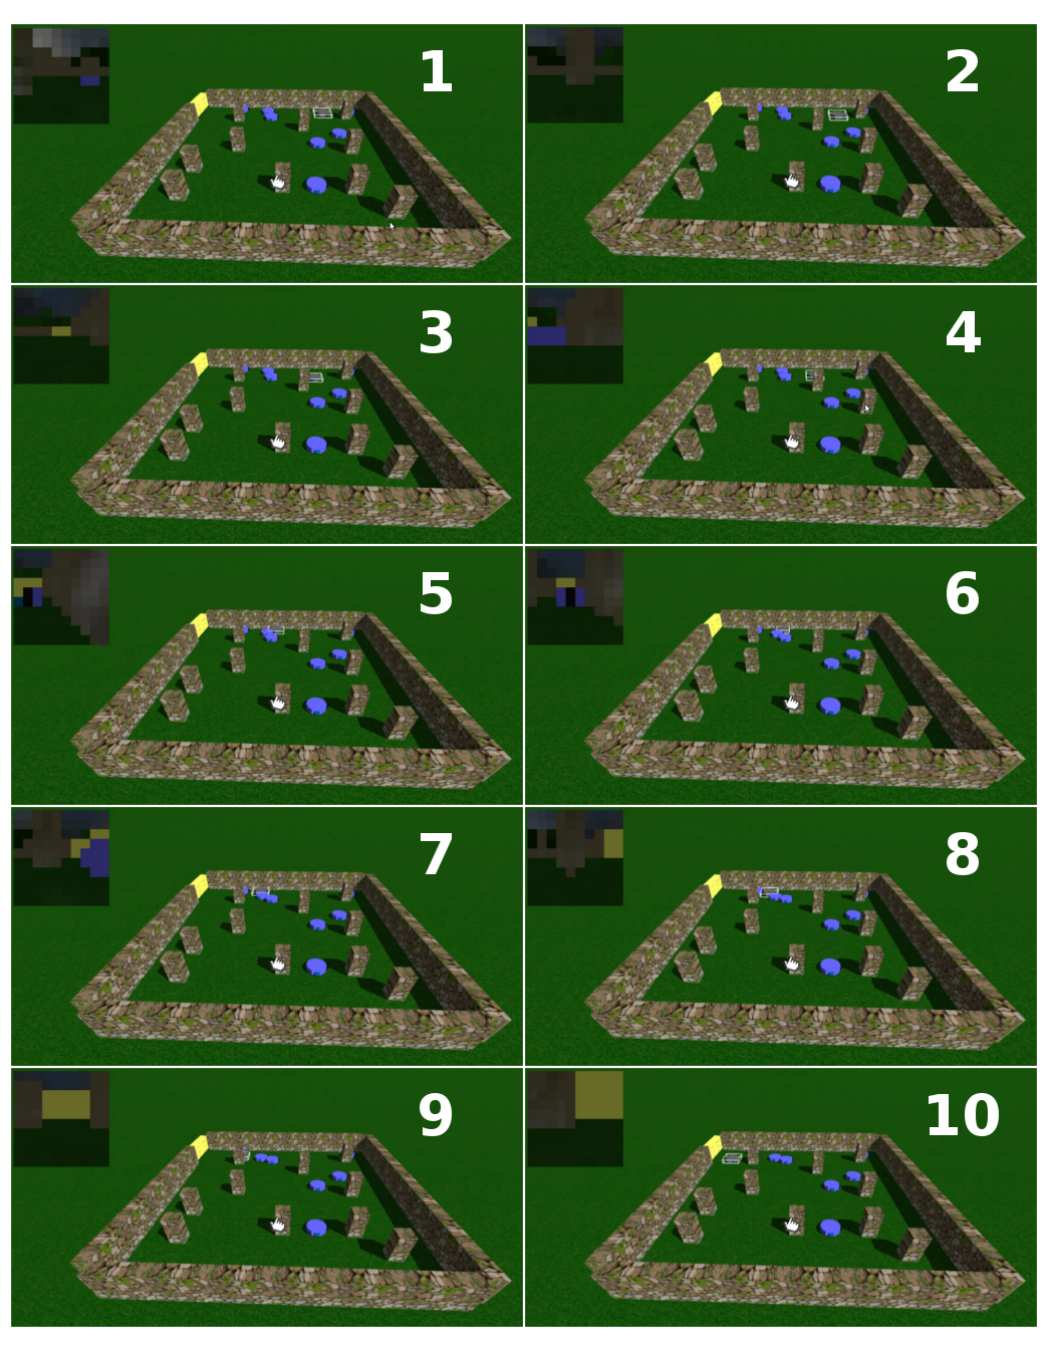
Fig. 10. Agent’s behavior in a situation with more pillars. As the number of obstacles reduces the avaliable area for locomotion, the agent pushes the robots on the way to the door, as can be noted in frames 5, 6, 7 and